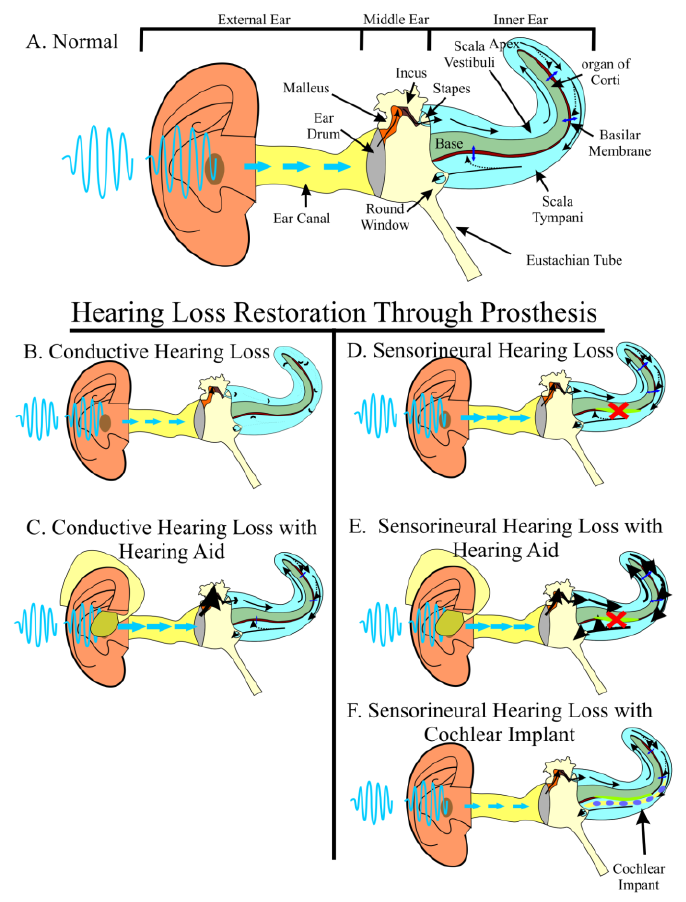
Figure 1. Hearing requires the precise stimulation of hair cells. Sound waves from the environment are funneled into the auditory canal by the external ear. Sound waves hit the ear drum and are turned into physical vibrations that are propagated through three middle ear bones, the malleus, the incus, and the stapes. The stapes articulates with the oval (cid:90)(cid:76)(cid:81)(cid:71)(cid:82)(cid:90)(cid:15)(cid:3) (cid:90)(cid:75)(cid:76)(cid:70)(cid:75)(cid:3) (cid:86)(cid:72)(cid:83)(cid:68)(cid:85)(cid:68)(cid:87)(cid:72)(cid:86)(cid:3) (cid:87)(cid:75)(cid:72)(cid:3) (cid:80)(cid:76)(cid:71)(cid:71)(cid:79)(cid:72)(cid:3) (cid:72)(cid:68)(cid:85)(cid:3) (cid:73)(cid:85)(cid:82)(cid:80)(cid:3) (cid:87)(cid:75)(cid:72)(cid:3) (cid:76)(cid:81)(cid:81)(cid:72)(cid:85)(cid:3) (cid:72)(cid:68)(cid:85)(cid:182)(cid:86)(cid:3) (cid:73)(cid:79)(cid:88)(cid:76)(cid:71) -filled scala vestibuli. Physical vibrations of the middle ear bones are converted into compression and rarefaction of the perilymphatic fluid. The scala vestibuli is continuous with the scala tympani. As the fluid waves propagate through the scalae, they cause vibrations of the overlaying basilar membrane. This vibration results in a shearing force of organ of Corti hair cells against the tectorial membrane to activate the auditory nerve ( A ). Light blue arrows indicate sound wave movement. Black arrows indicate vibration and fluid movement. Dark blue arrows indicate basilar membrane vibration. In conductive hearing loss ( B ), sound waves are not accurately propagated to the inner ear. Hearing aids ( C ) can amplify sound waves to overcome this dampening effect. In sensorineural hearing loss ( D ), hair cells are lost. Hearing aids ( E ) can partially overcome the resulting hearing deficit by increasing the amplitude to nearby cells; however, no hearing aid can stimulate lost hair cells and furthermore, hearing aids may create discomfort by over-stimulating remaining hair cells. The best current treatment for sensorineural hearing loss is cochlear implants ( F ) which directly stimulate auditory neurons through an electrode array surgically implanted into the inner